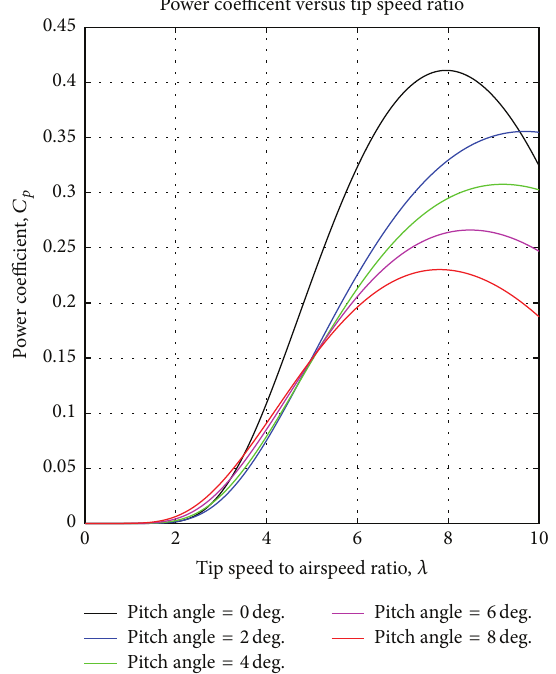
Figure 1: The power coefficient 𝐶 𝑝 and its variation with 𝜆 and the blade pitch